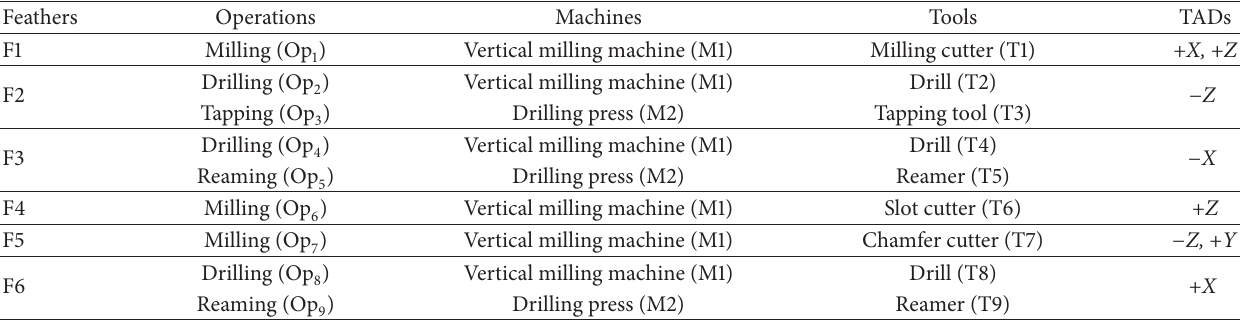
Table 1: Operation selection for the example part.